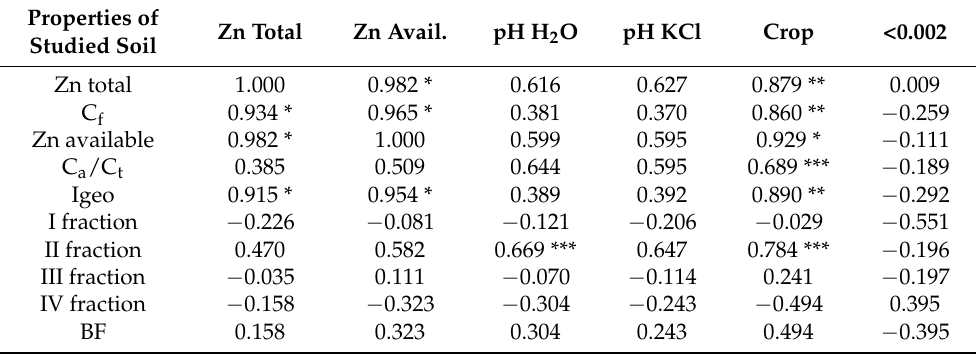
Table 2. Values of Pearson’s correlation coefficients of zinc forms and indices with the physicochemi- cal properties of sandy soils.